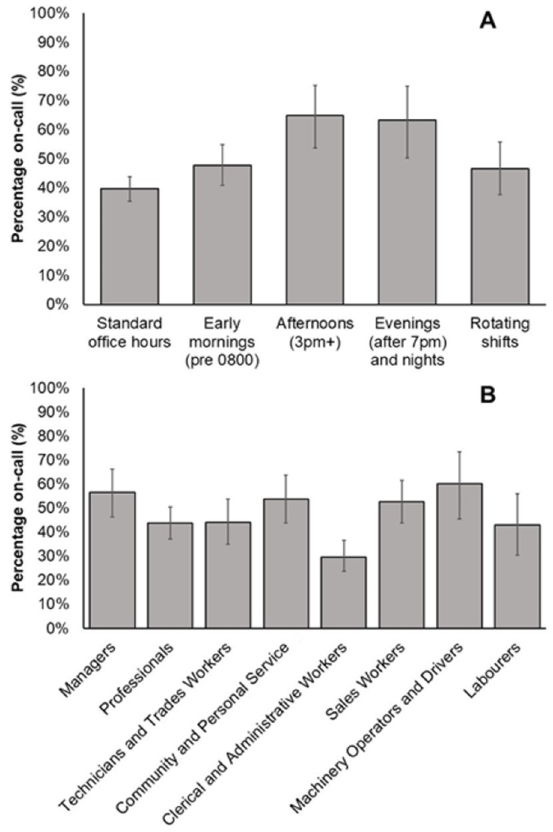
Fig 1. Workers reporting on-call over the previous month. Proportion ( ± 95% Confidence Interval) of workers by work schedule (Panel A) and occupation type (Panel B) who self-reported being on-call at least once in the preceding